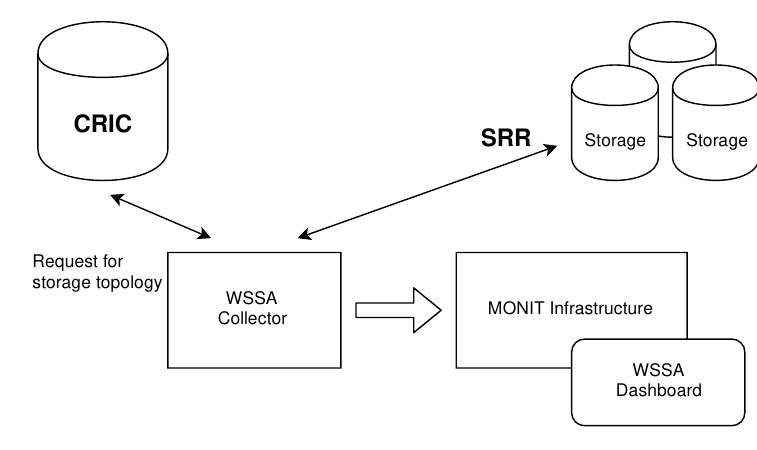
Figure 2. Expected data flow using CRIC and